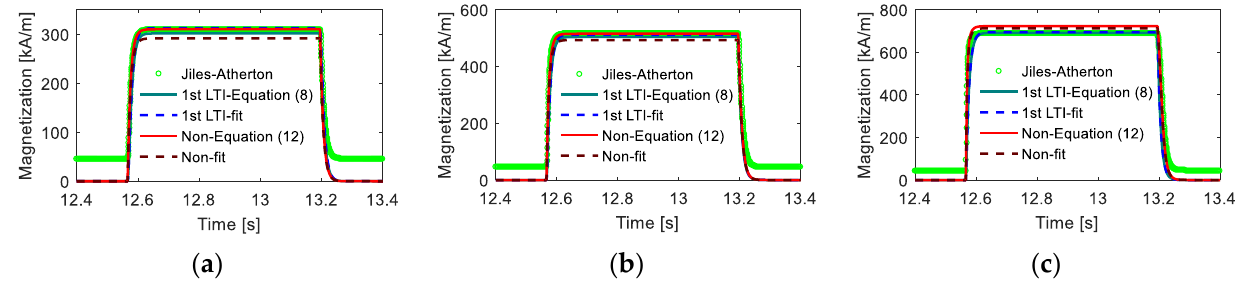
Figure 17. Time-domain responses calculated from different models ( a ) low magnetic field intensity, ( b ) medium magnetic field intensity, ( c ) high magnetic field intensity.